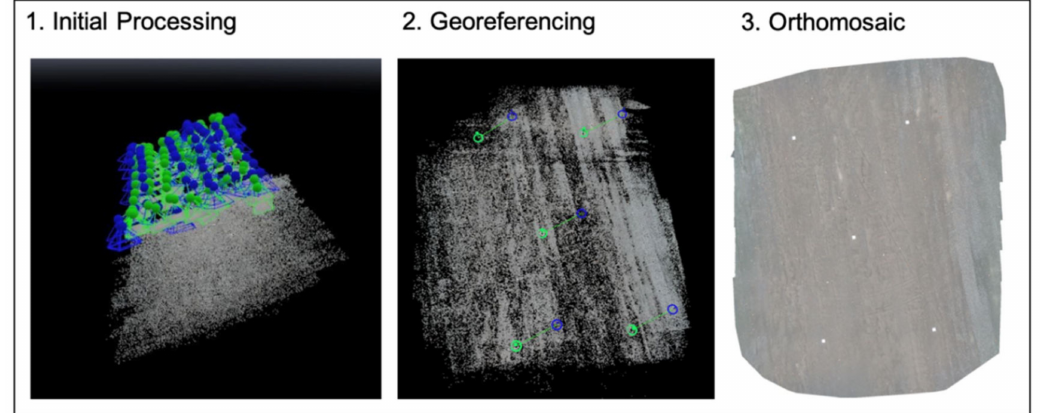
Figure 5. Workflow to generate georeferenced orthophotos using Pix4D